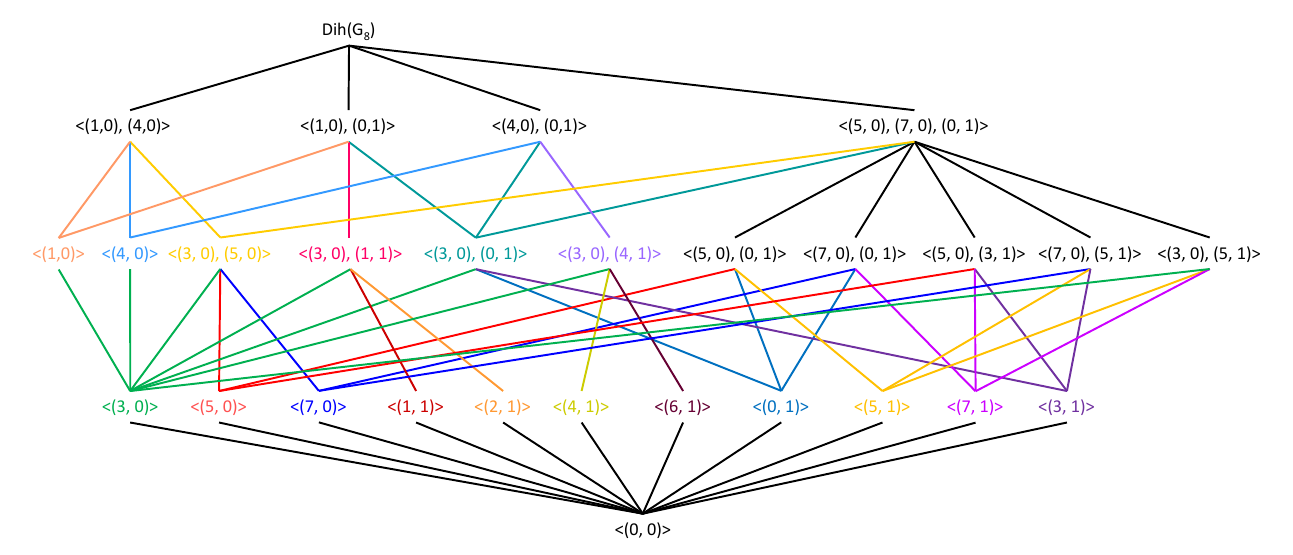
Figure 1. The subgyrogroup lattice of the gyrogroup Dih ( G 8 )